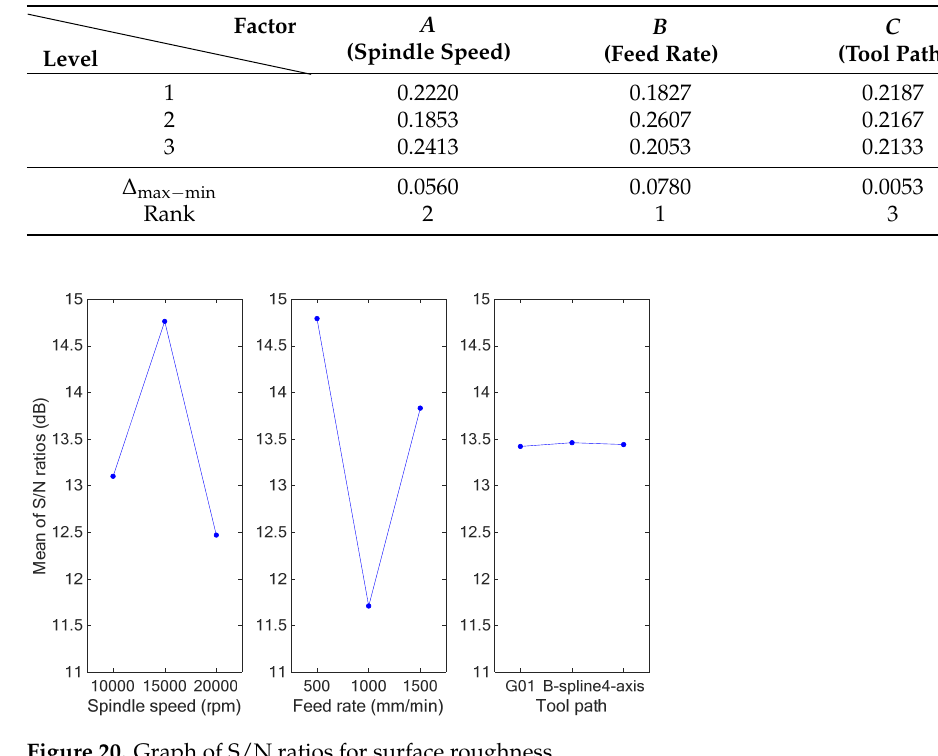
Table 17. ANOVA for surface roughness.